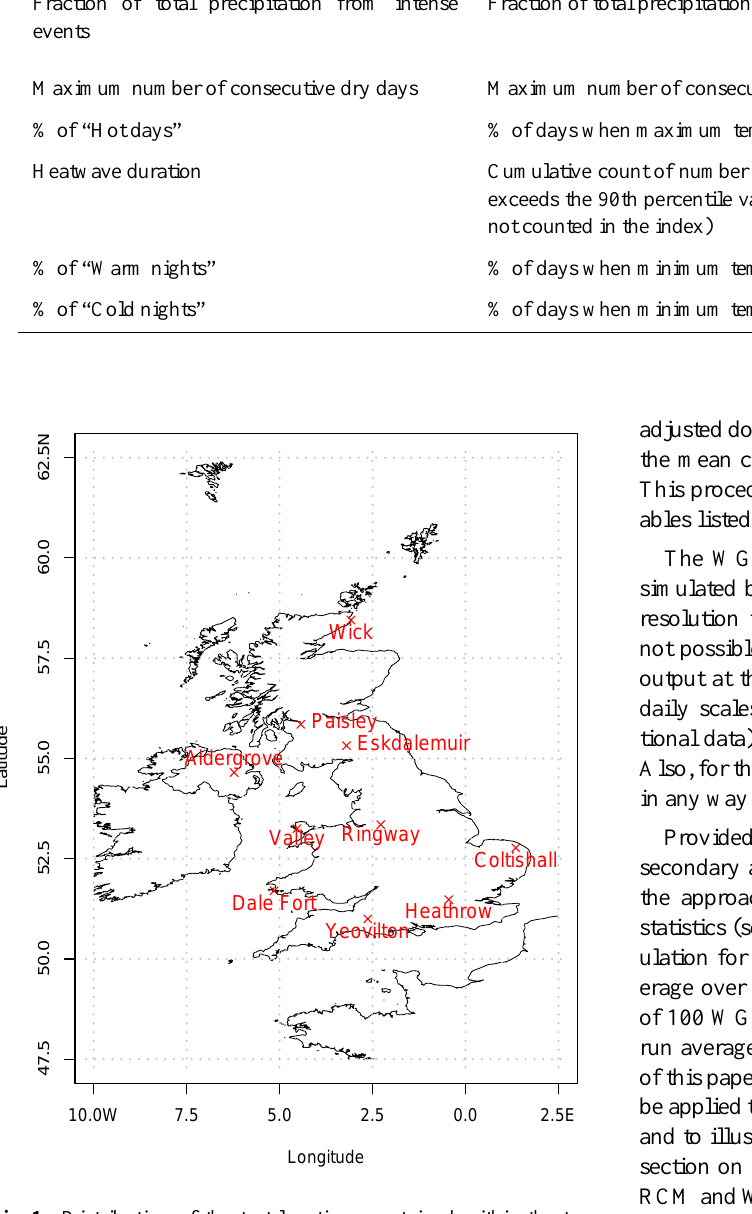
Fig. 1. Distribution of the test locations contained within the ten RCM grid cells